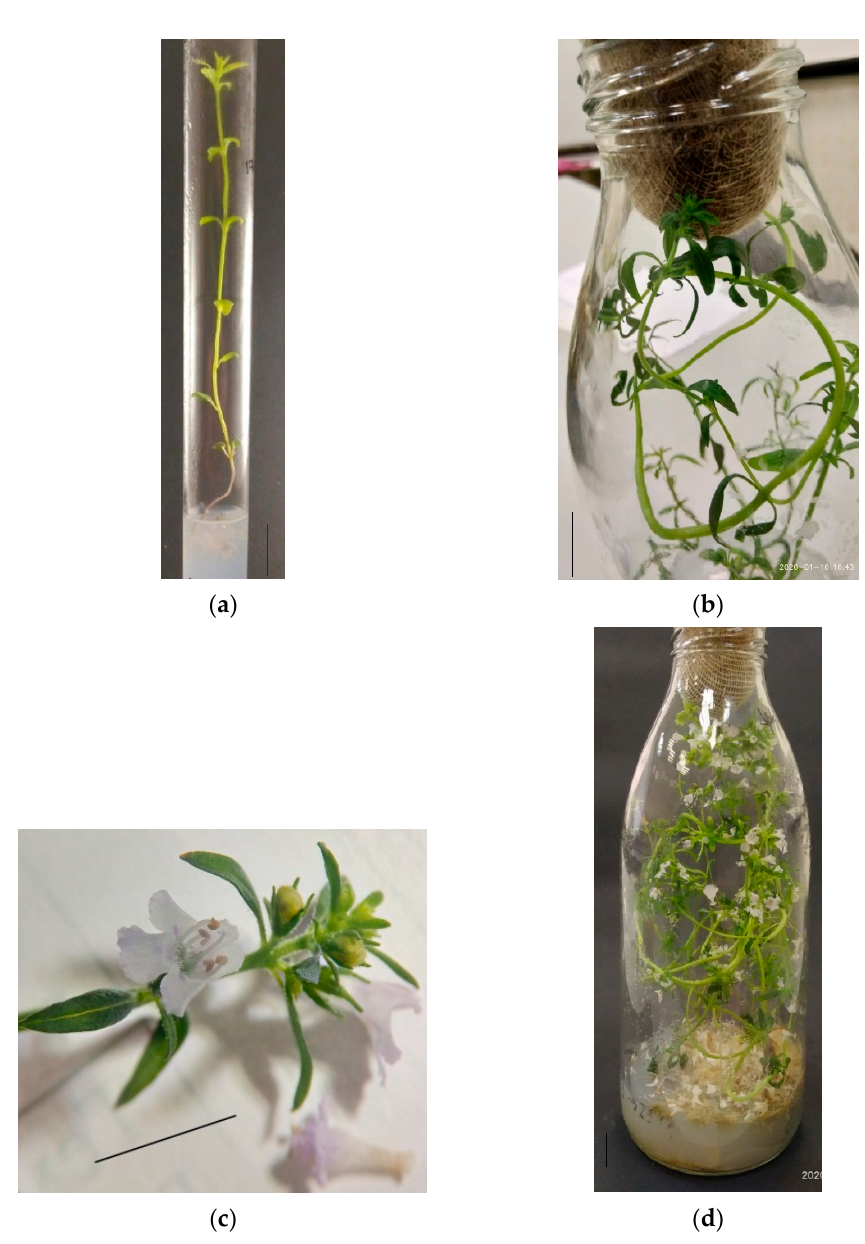
Figure 1. Appearance of S. hortensis aseptic plants: ( a ) initial culture, ( b ) 2nd subculture, ( c ) 3rd subculture, and ( d ) aseptic plant shoot of the 3rd subculture with flower buds and flowers. Bars—0.5 cm. Flavonoid content in S. hortensis aseptic plants. The total flavonoid content in different organs was measured during three subcultures to study the characteristics of flavonoid accumulation in S. hortensis aseptic plants (Table